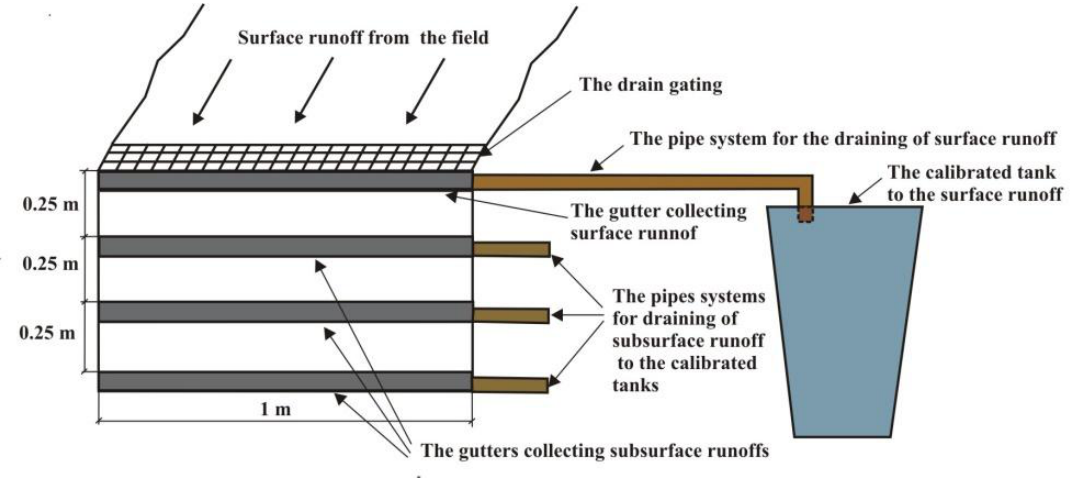
Figure 2. Schema of the catcher surface and subsurface runoff.